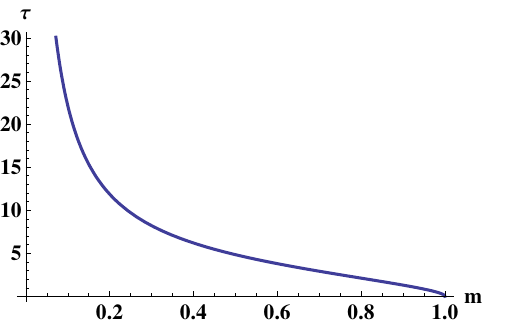
Figure 6 . (cid:28) in terms of m given by (3.10) (here (cid:21) = (cid:0) 1). For any given (cid:28) > 0 and (cid:21) < 0 there is a unique solution m to the normalization condition.